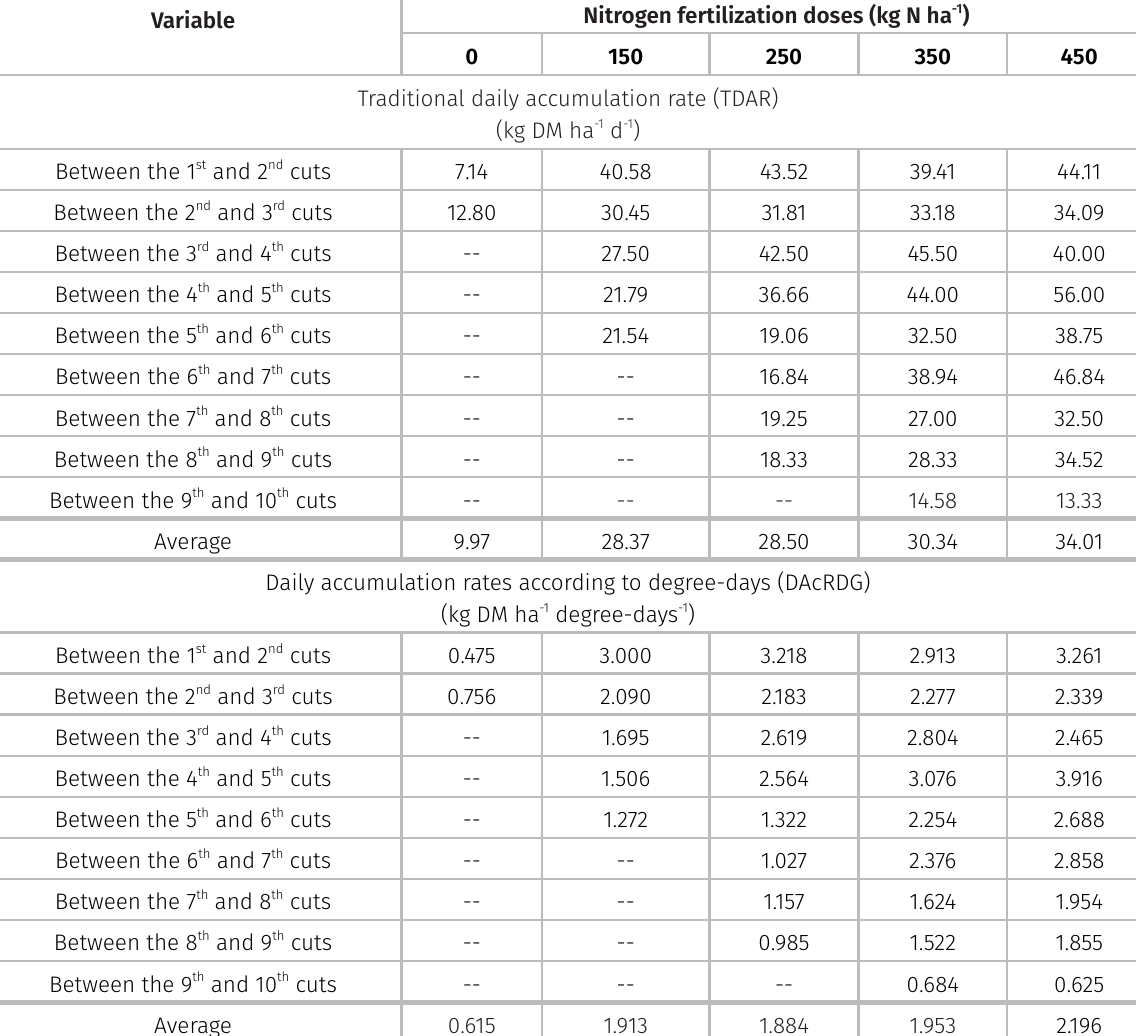
Table V. Traditional daily accumulation rate (TDAR) and daily accumulation rate for each accumulated degree-day (DAcRDG) for dual-purpose wheat pasture BRS Tarumã managed with different nitrogen